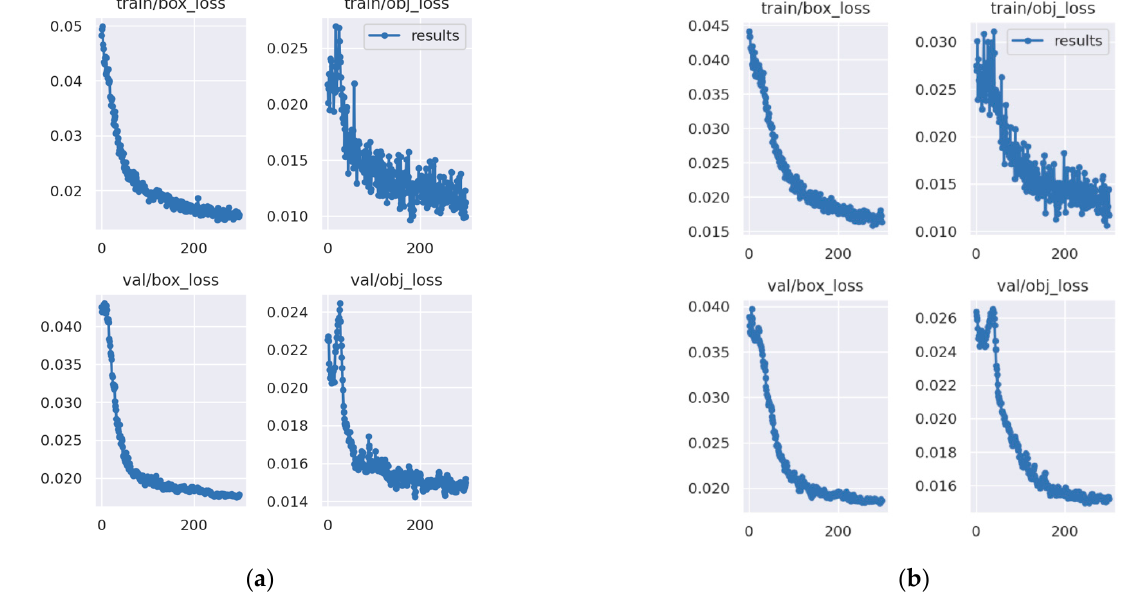
Figure 14. ( a ) SE attention mechanism not added; ( b ) adding SE attention mechanism.